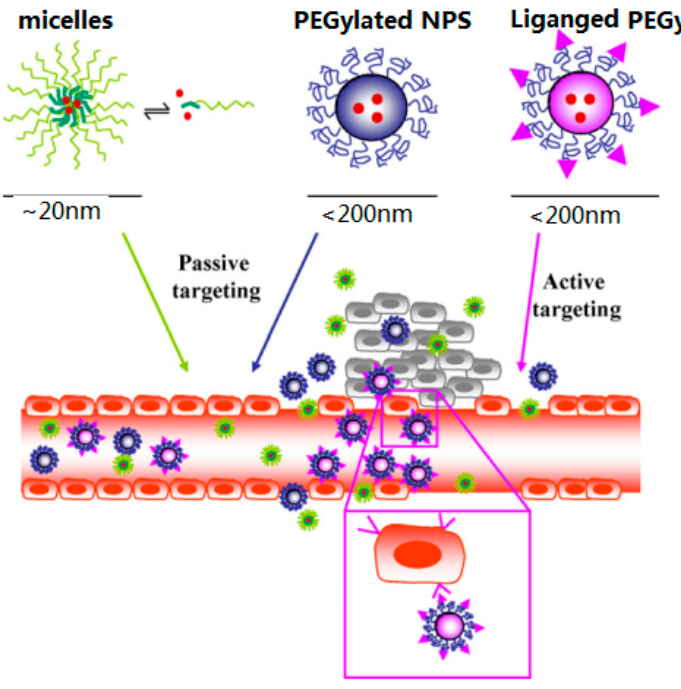
Figure 1. Schematic presentation of passive and active PDT. Reprinted from International Journal of Pharmaceutics, 392, Fabienne Danhier et al., Active and passive tumor targeting of a novel poorly-soluble cyclin-dependent kinase inhibitor, JNJ-7706621, 20–28., Copyright (2010), with permission from Elsevier [67].